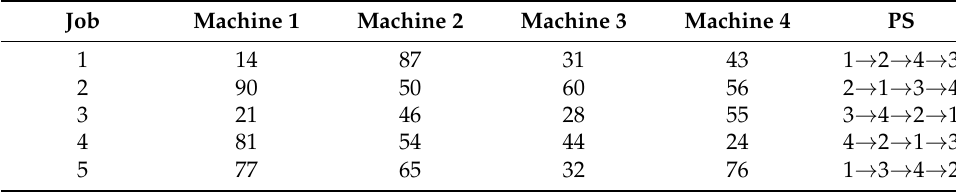
Table 3. Job shop production system with four machines and five operations.